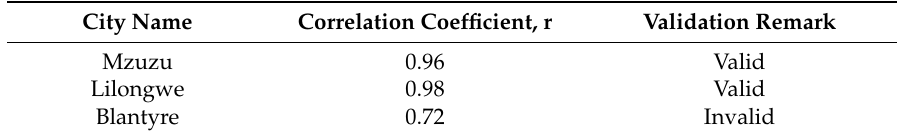
Table 9. Validation test